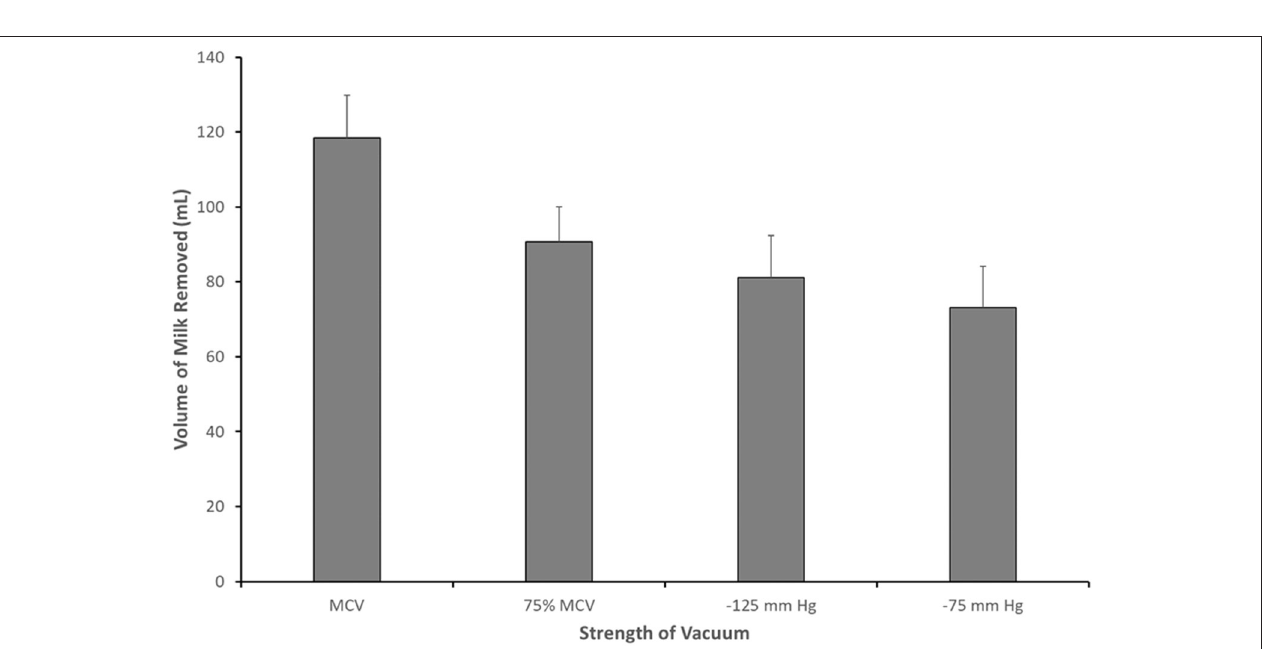
FIGURE 3 | Volume of milk removed when pumping at maximum comfortable vacuum (MCV; − 190.7 ± 8.0mm Hg), 75% of MCV ( − 143.0 ± 8.8mm Hg), − 125 and − 75mm Hg [Data adapted from Kent et al. (30)].